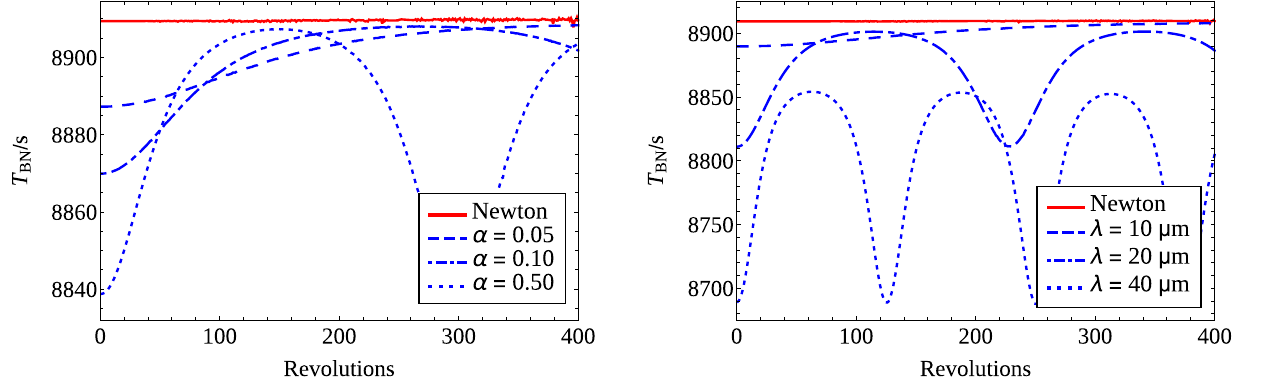
Fig. 6 Revolution period of S around P (in seconds) for the first 400 revolutions, for different values of ( λ,α ). Left panel: λ = 10 μ m, α = 0 . 05 μ m, 0 . 10 μ m and 0 . 50 μ m (blue dashed, dot-dashed and